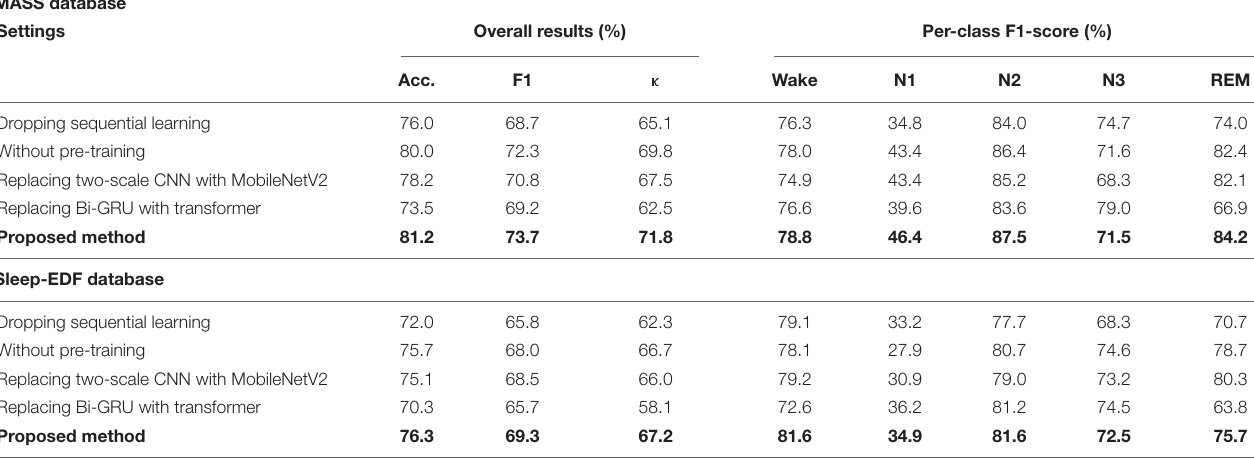
TABLE 4 | Results of ablation